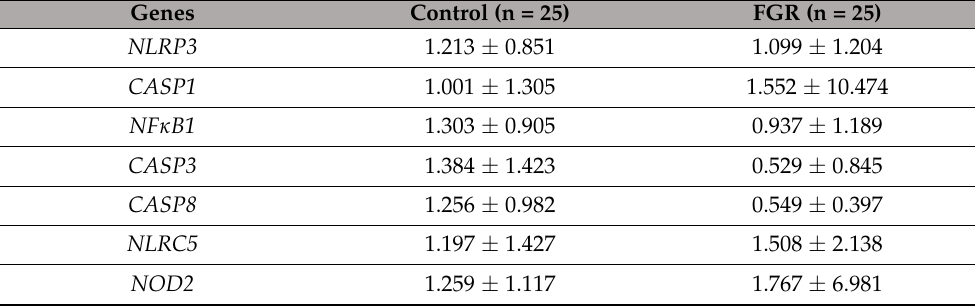
Table 3. Fluidigm Biomark TM Array showed the presence of DAMPs.